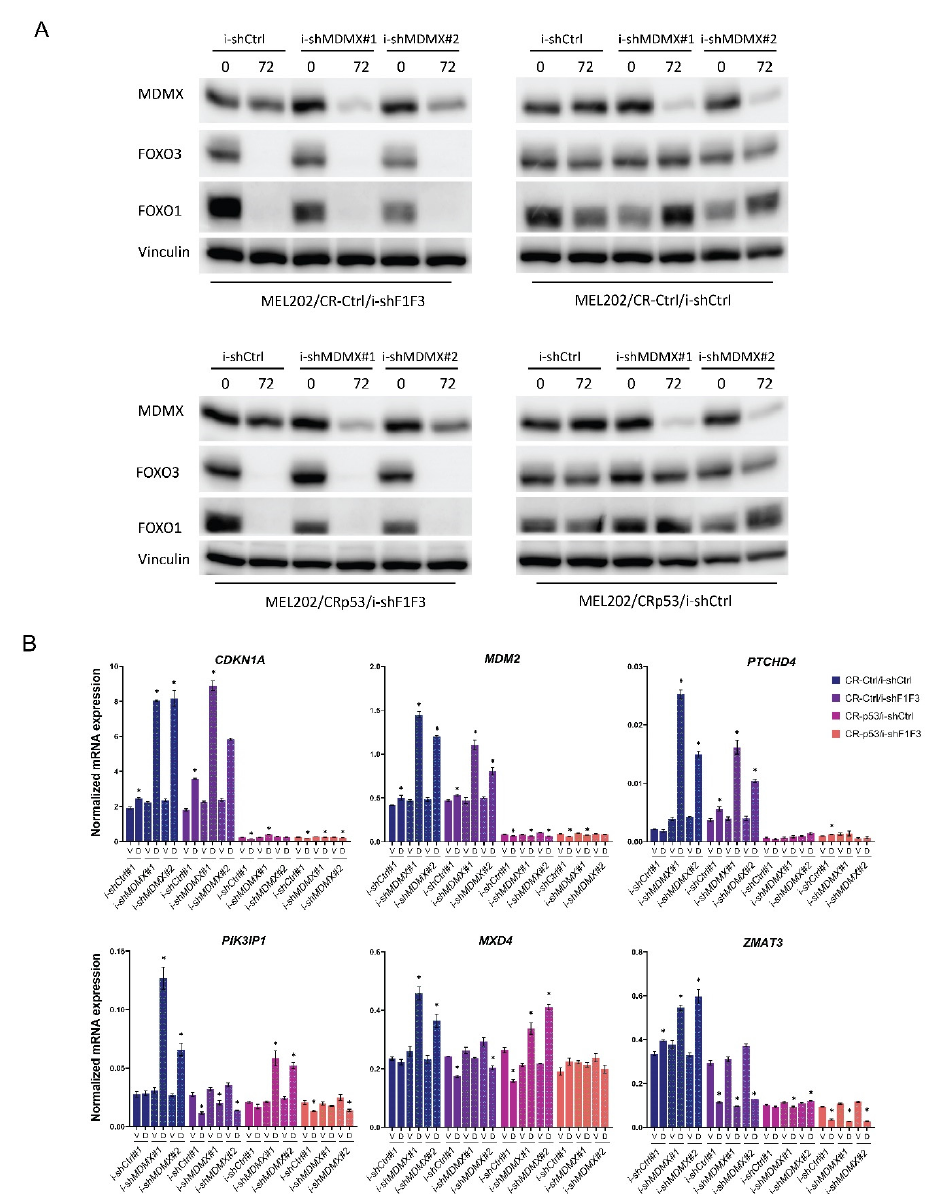
Figure 3. Expression of some MDMX target genes is FOXO-dependent. Analyses of MEL202/CR-Ctrl and MEL202/CRp53 cell lines, with and without 2 distinct i-shMDMX shRNAs, with and without i-shFOXO, plus and minus doxycycline treatment. ( A ) Indicated cell lines were treated for 72 h with 10 ng/mL doxycycline after which protein lysates were harvested and expression of designated proteins was analyzed to assess the efficacy of depletion. ( B ) The various cell lines were treated for 72 h with 10 ng/mL doxycycline (D) or Vehicle (V) after which RNA was harvested and the expression of indicated genes was analyzed by real-time qPCR. Significant alterations ( p < 0.05) in expression levels are indicated with *. Original blots see Supplementary File